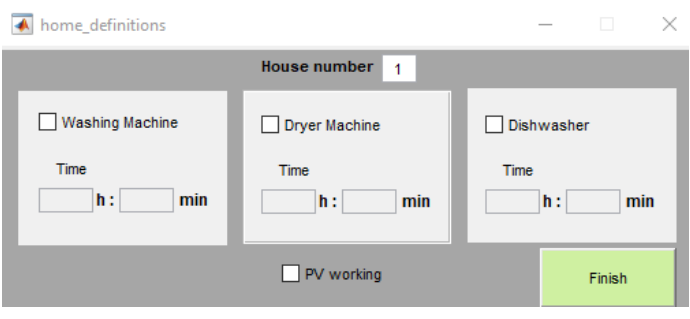
Figure 12. House profile.